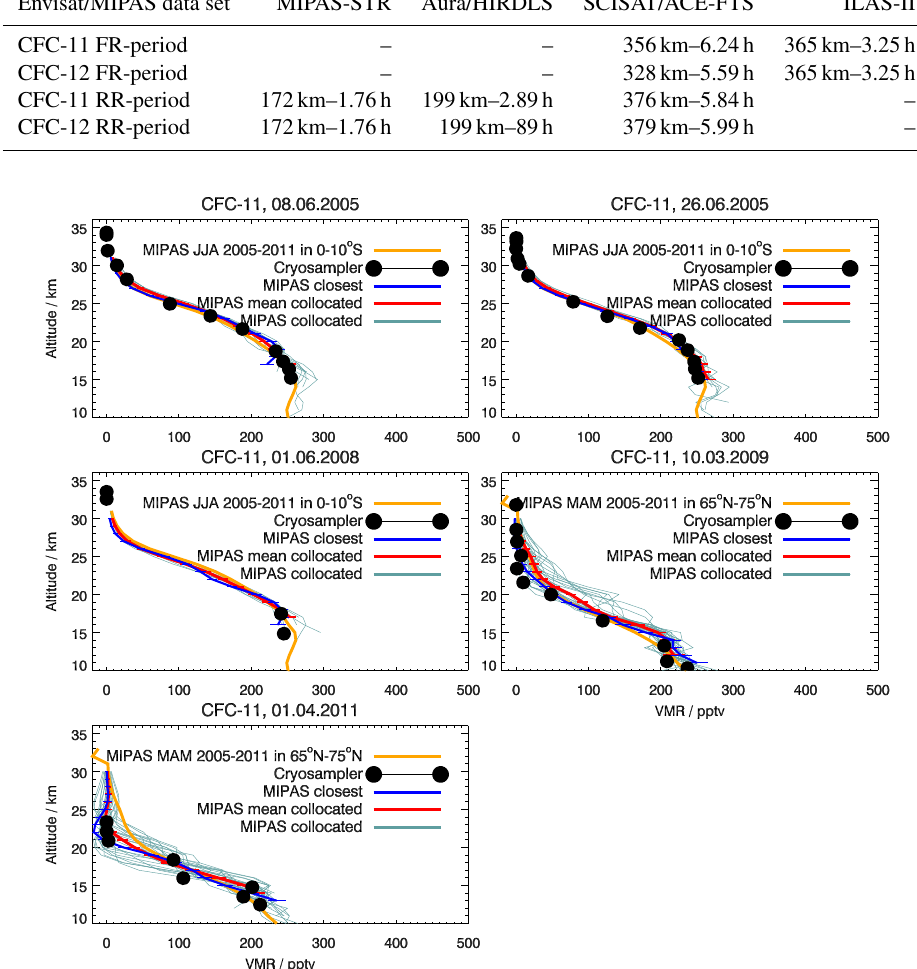
Figure 2. Comparison of a climatological mean of MIPAS CFC-11 measurements (light orange line), collocated measurements (blue-grayish lines) and their mean profile (red line) and the closest MIPAS profile (blue line) with different flights of the cryosampler (black